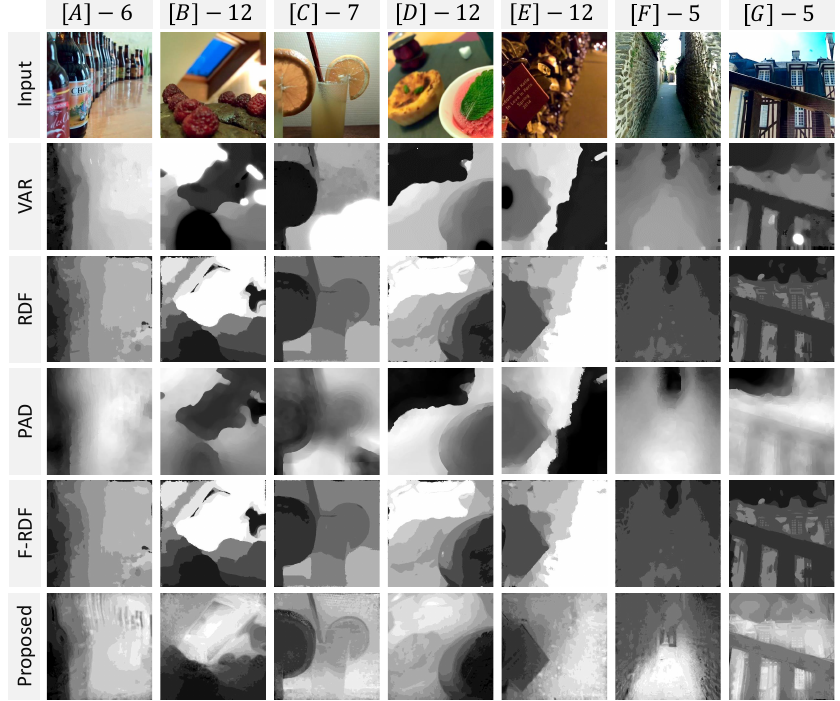
Figure 17. Qualitative evaluation on Lytro dataset [49] with recent (state-of-the-art) . The proposed method provide more accurate depth than other methods. ( A )—beers (6 frames), ( B )—cake (12), ( C )—cocktails (7), ( D )—dessert (12), ( E )—love-locks (12), ( F )—street (5), ( G )—wooden-house